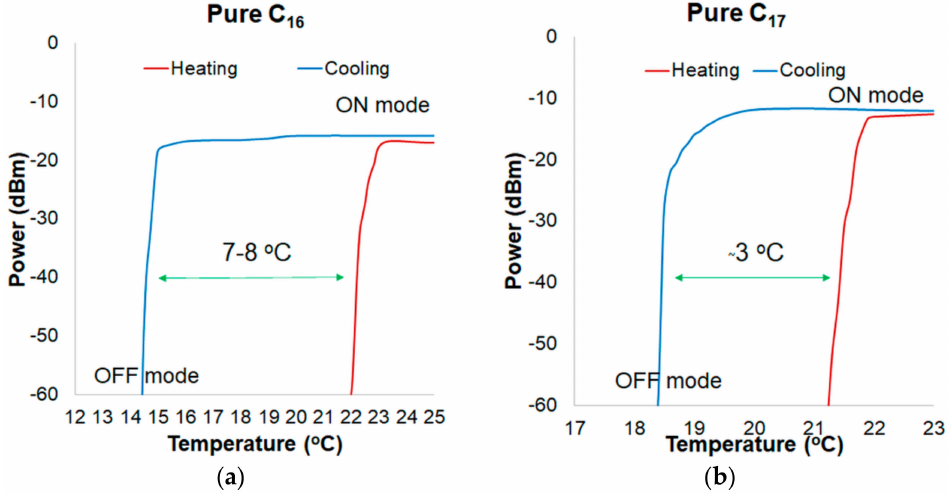
Figure 6. Hysteresis of power changing for a wavelength of 810 nm for ( a ) pure C 16 and ( b ) pure C 17